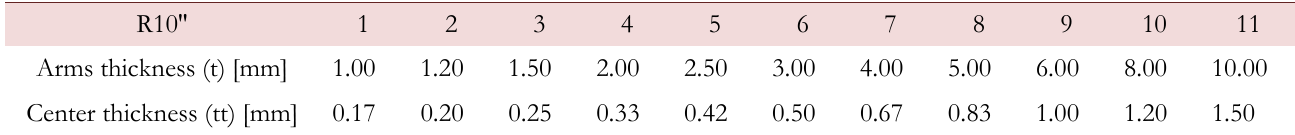
Table 2: Design variables used in the specimen design geometry